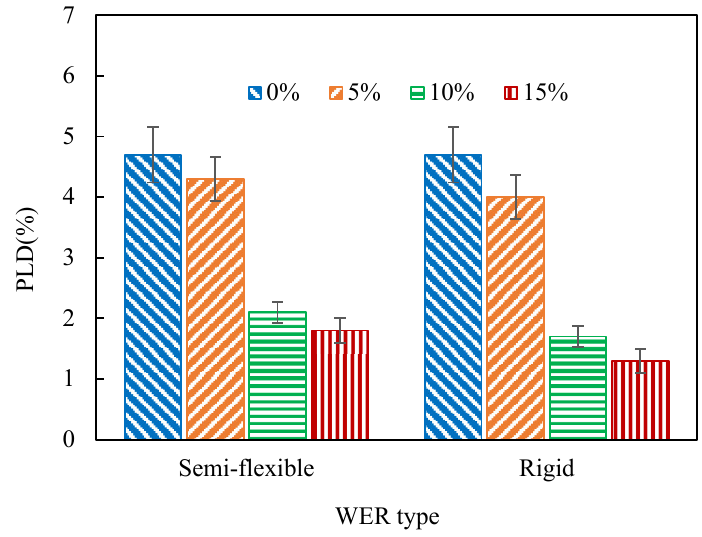
Figure 23. Slurry rutting test result .